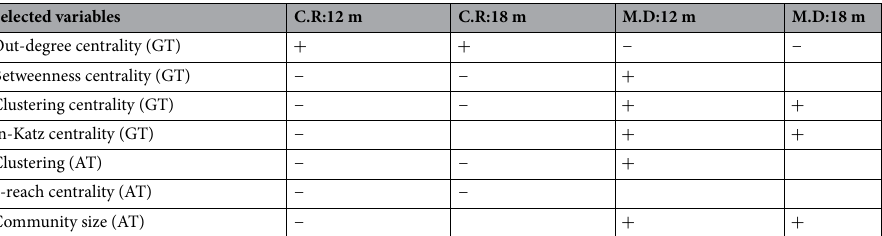
Table 2. Penalized multivariate regressions for system wide firm-based (GT) metrics and community-based metrics (AT). −, + denote the sign of the coefficient for significant variable. The variables not significant are not reported. The model is estimated by using Elastic Net regression. Each column corresponds to alternative definition of the dependent variable. In columns 1 and 2, the dependent variable is computed as cumulative returns over respectively 12 months and 18 months. In columns 3 and 4, the dependent variable is computed as the maximum drawdown over 12 months and 18 months, respectively.